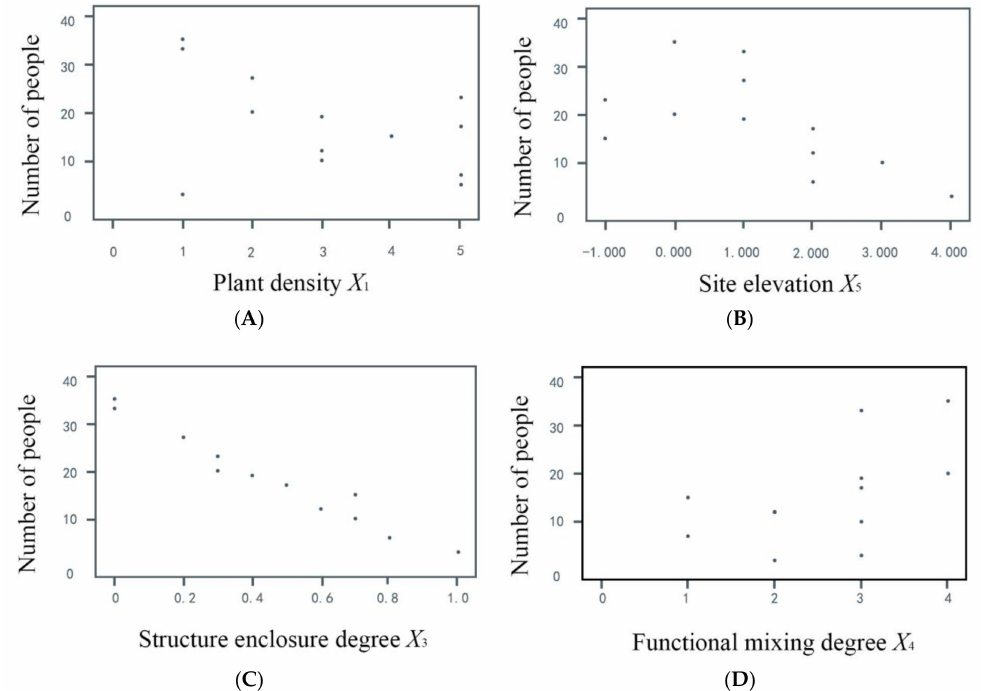
Figure 7. Site conditions and number of people. ( A ) Plant density is positively correlated with number of people. ( B ) Site elevation is positively correlated with number of people. ( C ) Degree of structural enclosure is positively correlated with number of people. ( D ) Functional mixing degree is negatively correlated with number of